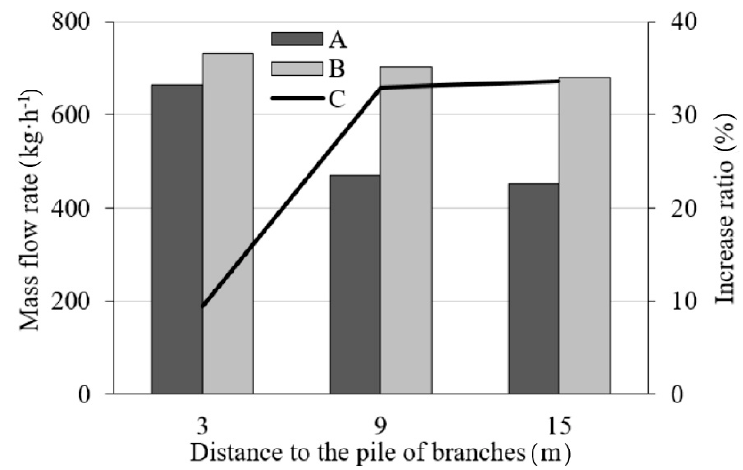
Figure 10. Mass productivity of the chipping process; A—for one operator, B—for two operators, C—